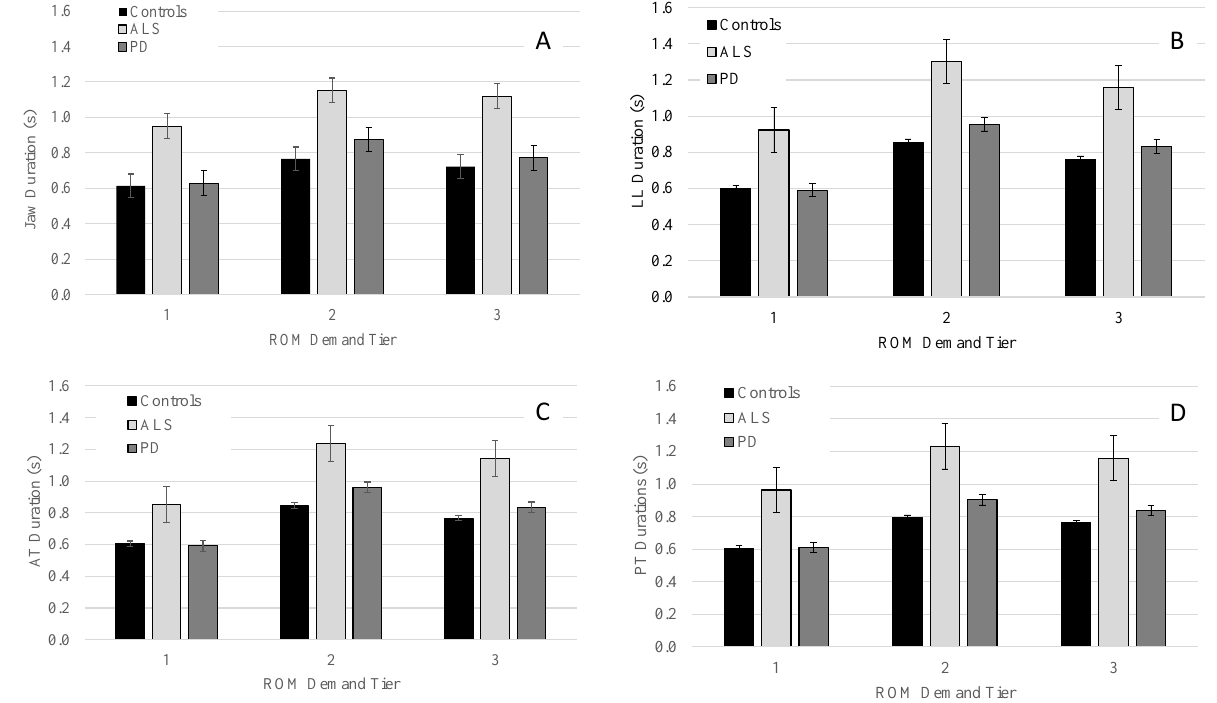
Figure 3. Group means (+/ − SE) for movement duration of the jaw (Panel ( A )), lower lip (Panel ( B )), anterior tongue (Panel ( C )), and posterior tongue (Panel ( D )) across all ROM demand tiers.